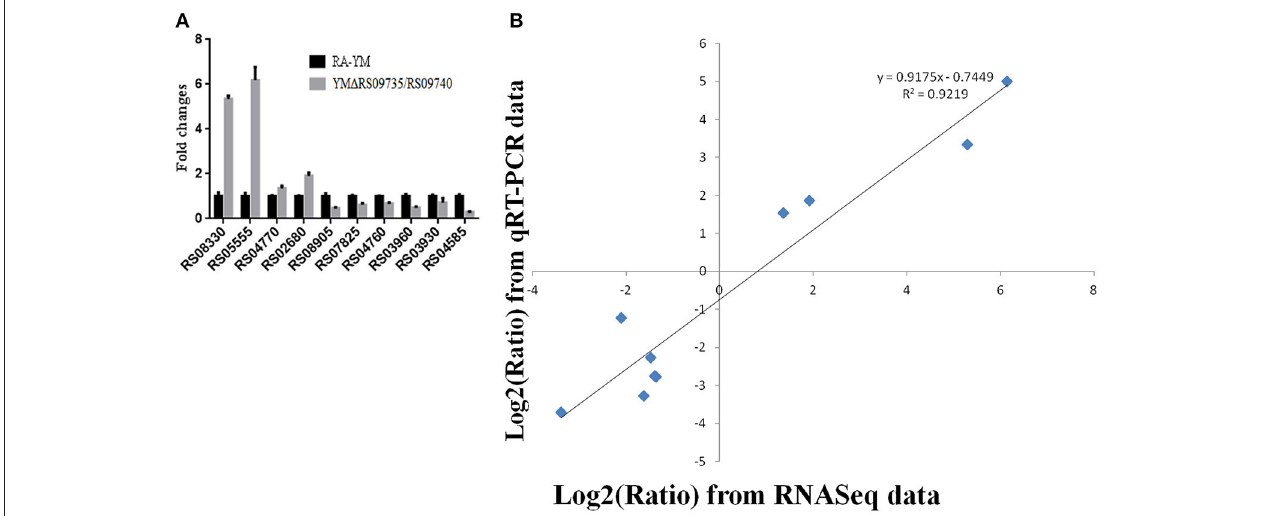
FIGURE 7 | Real-time PCR verification of differentially expressed genes in YM 1 RS09735/RS09740 mutant strain. (A) The fold expression changes of randomly selected 10 genes to validity of the RNAseq results. (B) Coefficient analysis of fold changes data between qRT-PCR and RNAseq. Ten different expression genes were selected from qRT-PCR.